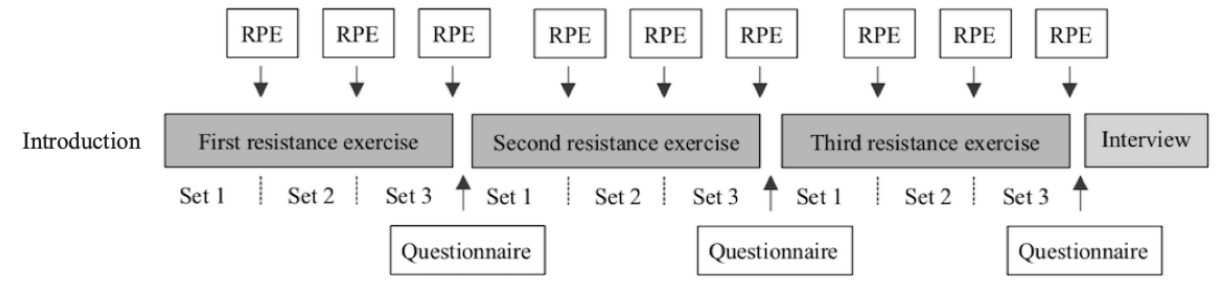
Figure 3. Study procedure. RPE: rating of perceived